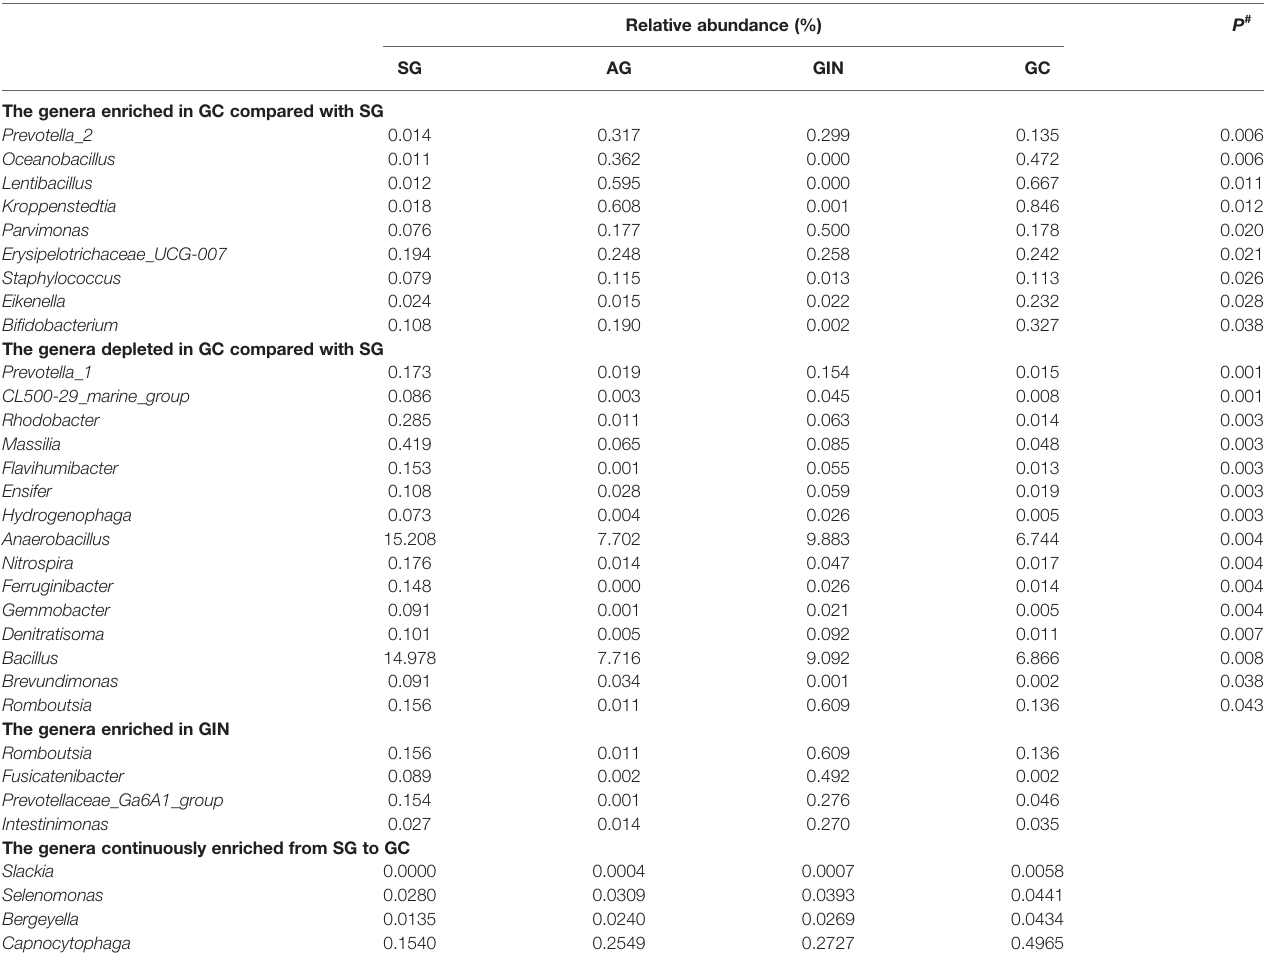
TABLE 1 | Relative abundance of selected genera in the four groups.